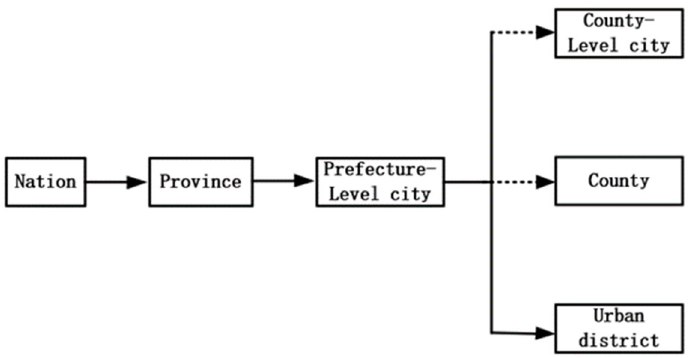
Figure 2. Administrative division of China. Source: Based on Tang and Hewings (2017) [8].